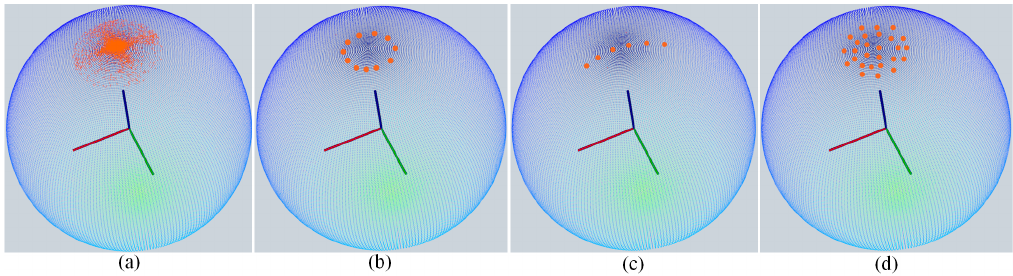
Figure 4. The Normal distributions on a normal sphere of different kinds of clusters after filtering with (3). ( a ) A horizontal plane, whose normals tend to obey a Gaussian distribution. ( b ) The normal distribution of a cone’s surface. ( c ) The normal distribution of a tube’s upper surface. ( d ) The normals of a sphere’s upper surface tend to follow a uniform distribution. Please note that only ( a ) is derived from real data, whereas the rest are synthesized for illustration